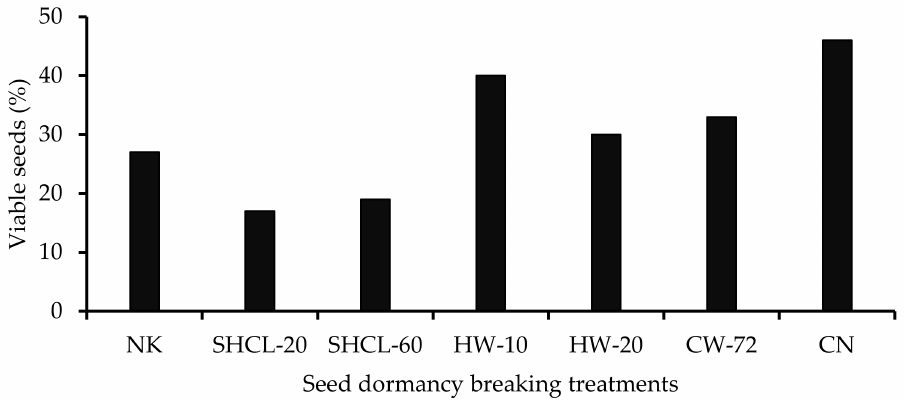
Figure 8. The relative percentage of viable seeds of D. steudneri after the end of the experiment in the seed laboratory. Nicking (NK), soaking in sodium hypochlorite for 20 min (SHCL-20), soaking in sodium hypochlorite for 60 min (SHCL-60), soaking in hot water for 10 min (HW-10), soaking in hot water for 20 min (HW-20), soaking in cold water for 72 h (CW-72), and the control